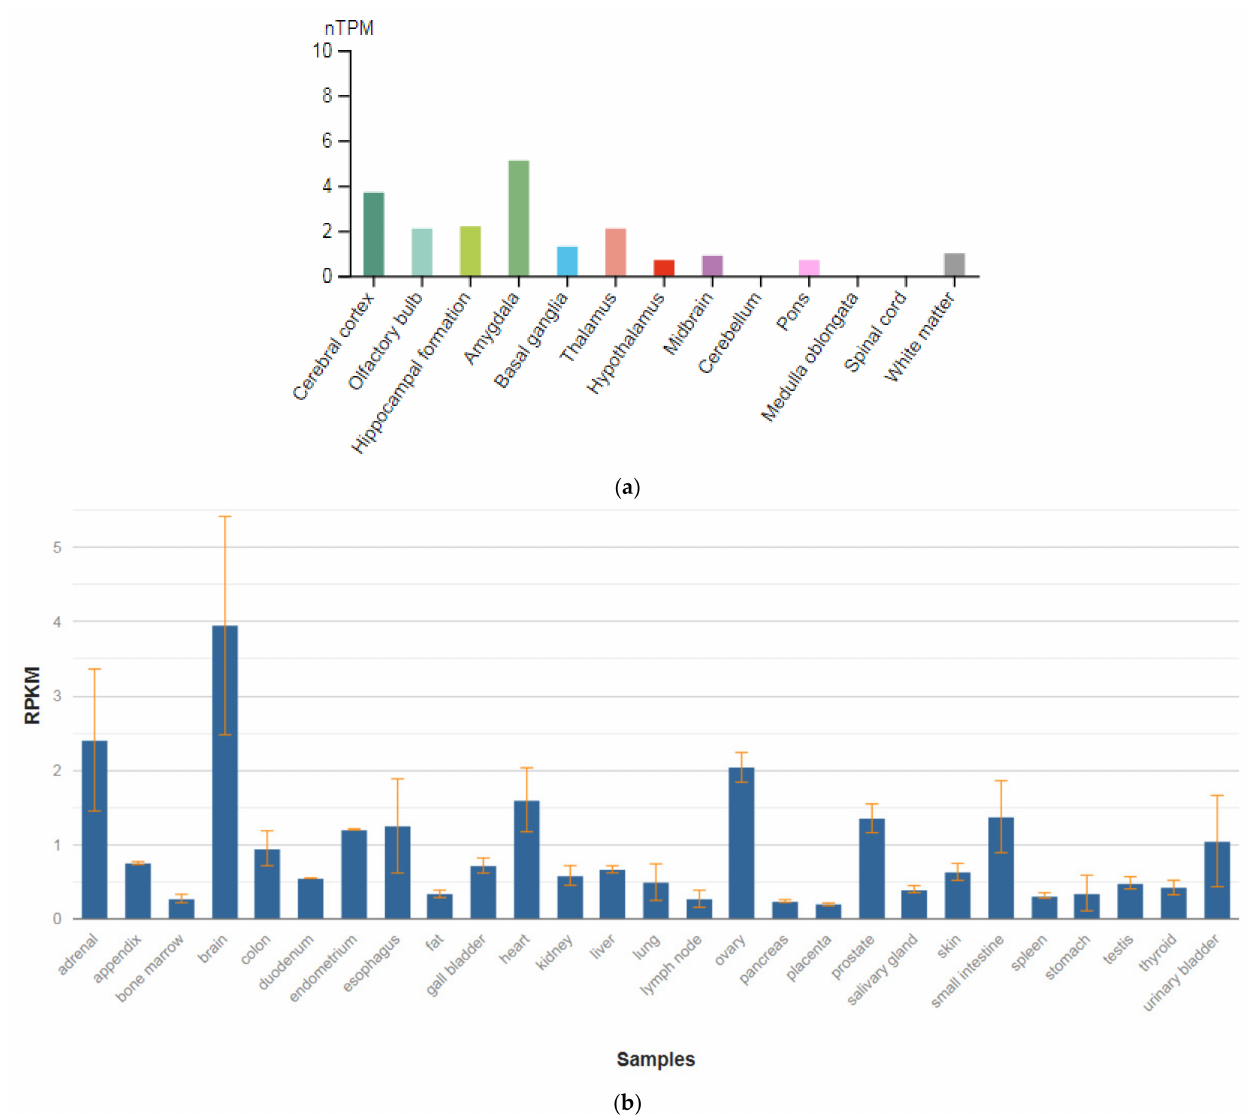
Figure 7. The tissue expression of calcium voltage-gated channel subunit alpha1 C in the brain ( a ) and other organs in the human body ( b